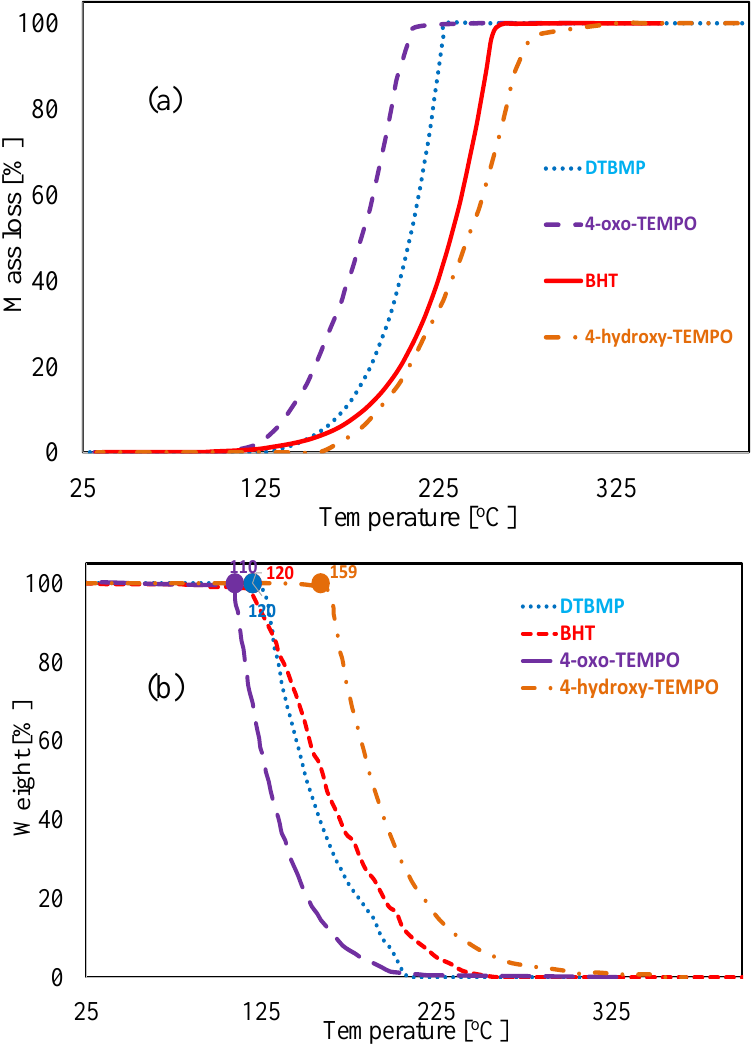
Figure 9. Thermogravimetric analysis of BHT, DTBMP, 4-hydroxy-TEMPO, and 4-oxo-TEMPO. ( a ) mass loss % and; (b) weight %.